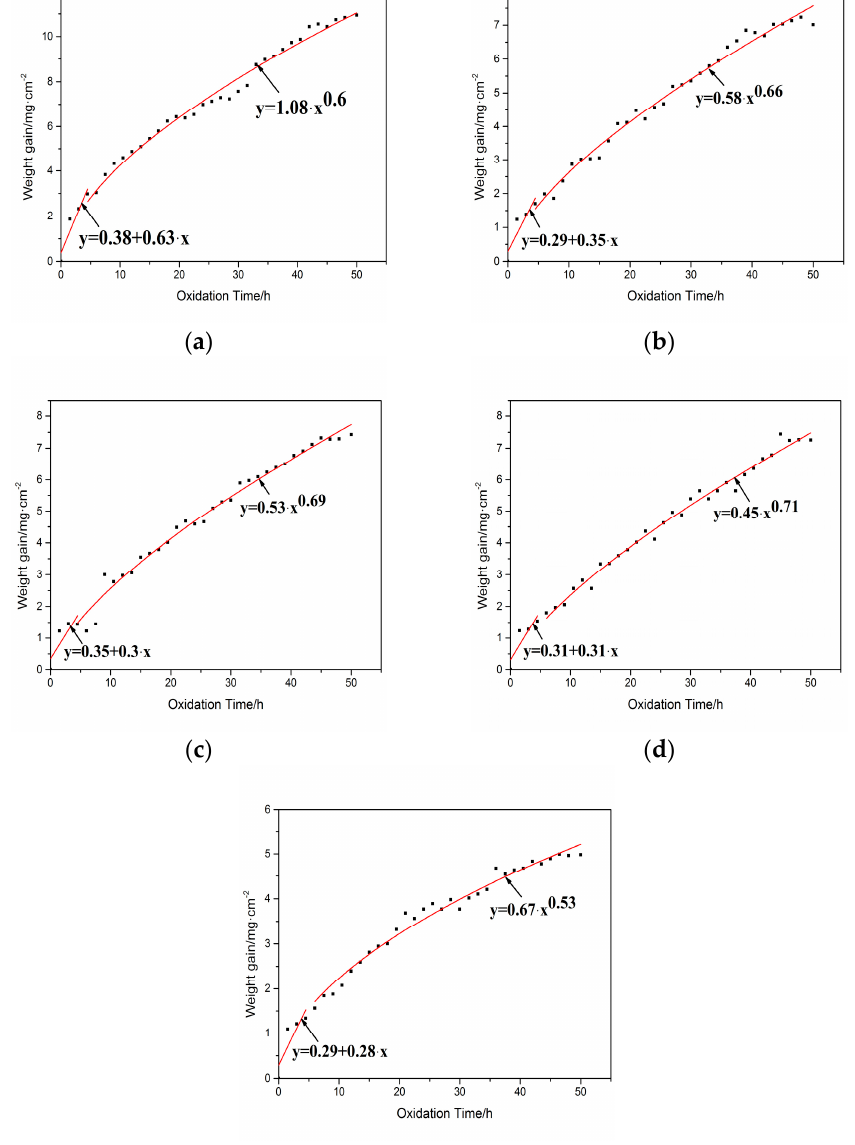
Figure 13. Oxidation weight gain fitted curves of the substrate and cladding coatings with different contents of Ti at 800 °C: ( a ) the substrate; ( b ) coating 1; ( c ) coating 2; ( d ) coating 3; ( e ) coating 4.